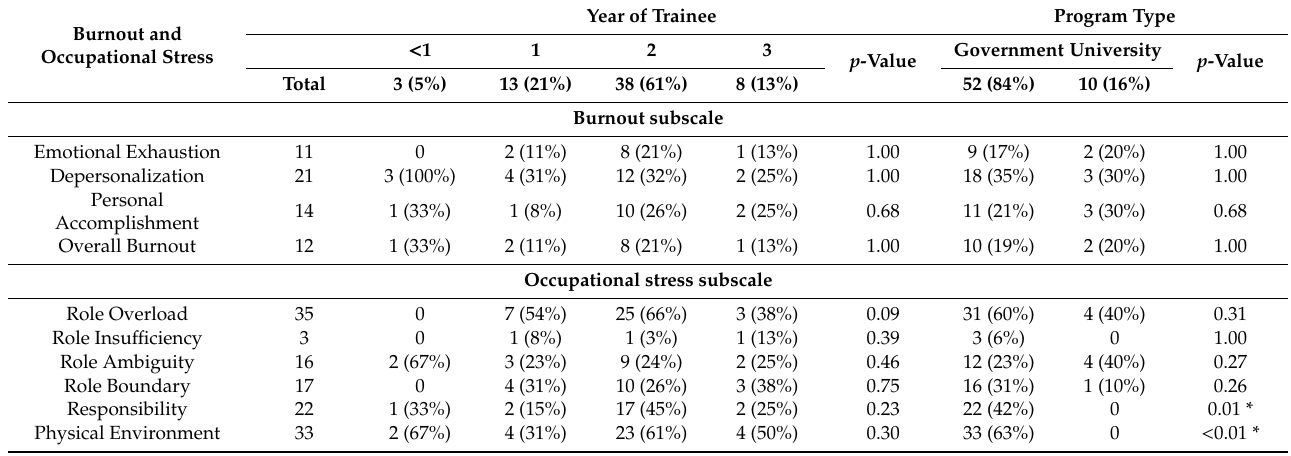
Table 2. Study sample and variables associated with occupational stress and burnout in univariate analysis.